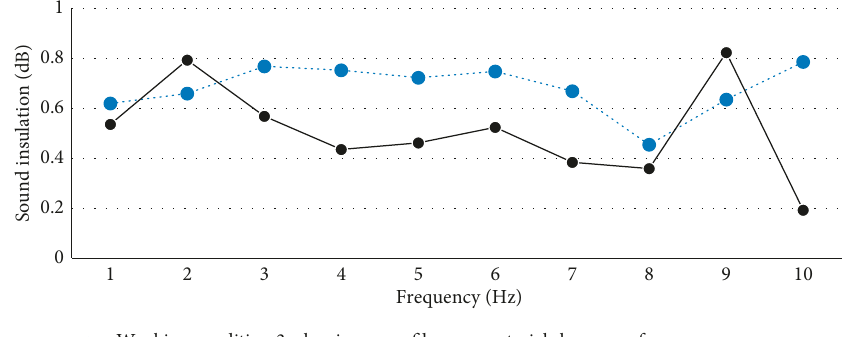
Figure 2: Comparison of the sound insulation of different materials of the heavy roof (120cm from the ground).